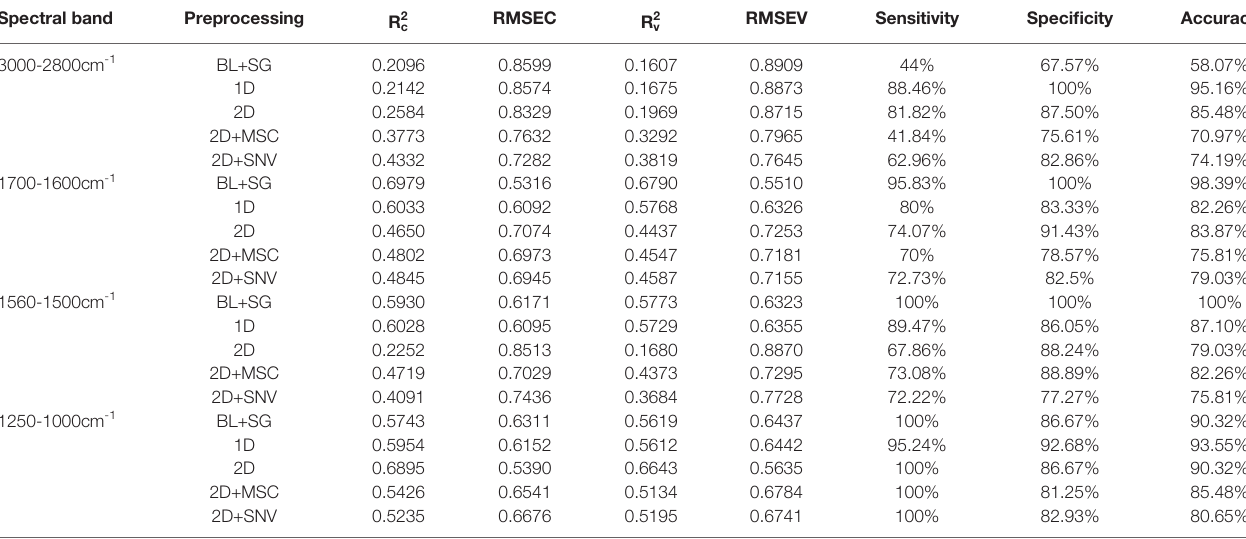
TABLE 2 | Calibration and validation results of PCR for the spectral data after